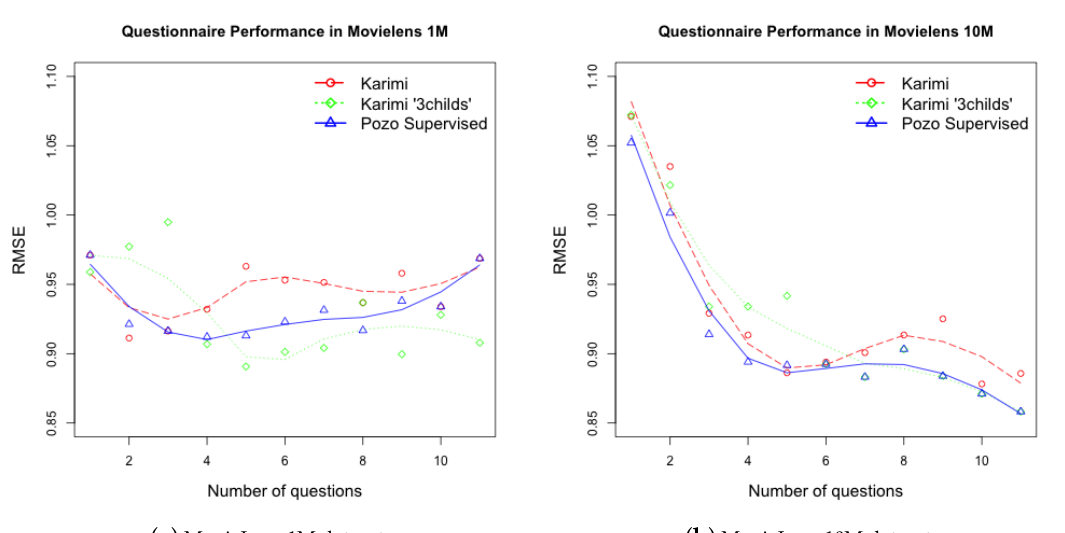
Figure 5. Questionnaire performance in